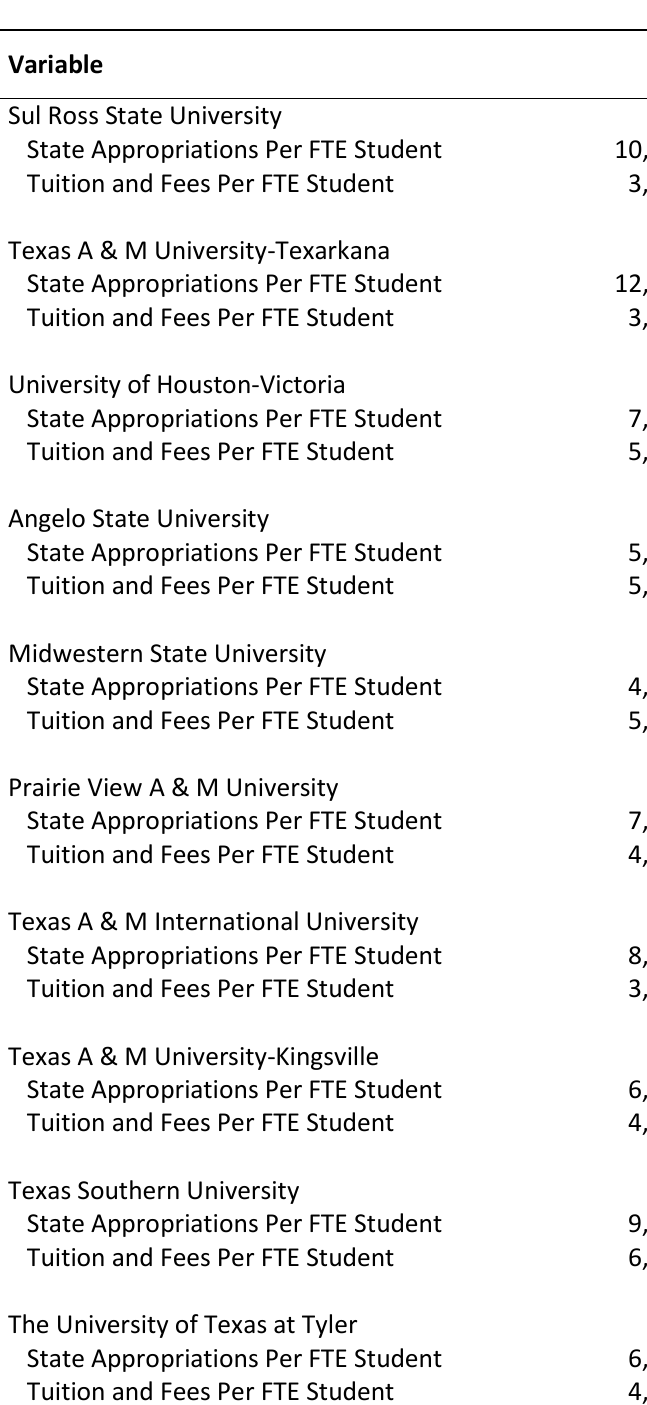
Table 3: Characteristics of